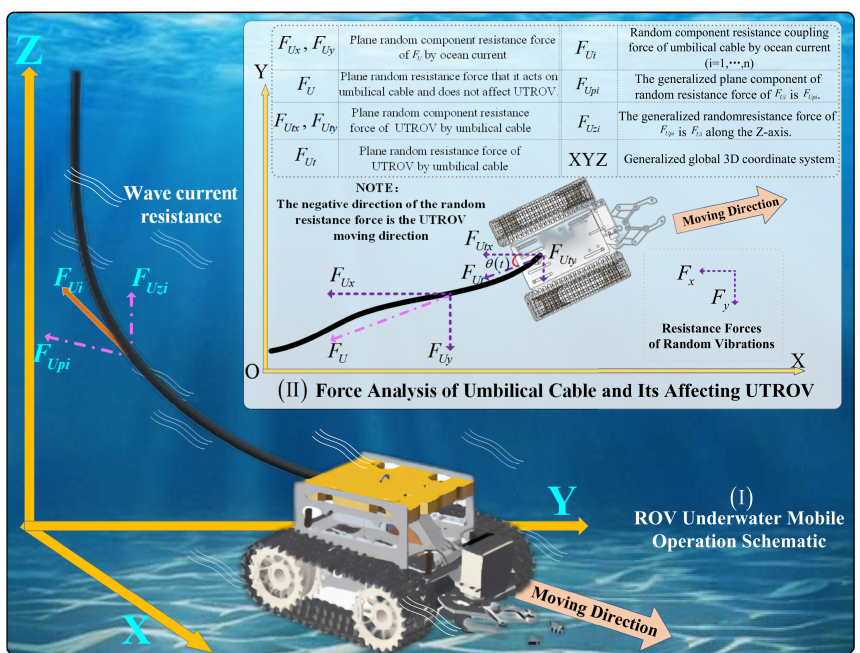
Figure 2. (I) Schematic of UROV trajectory tracking in global generalized coordinate system. (II) force analysis of random resistance acts on umbilical